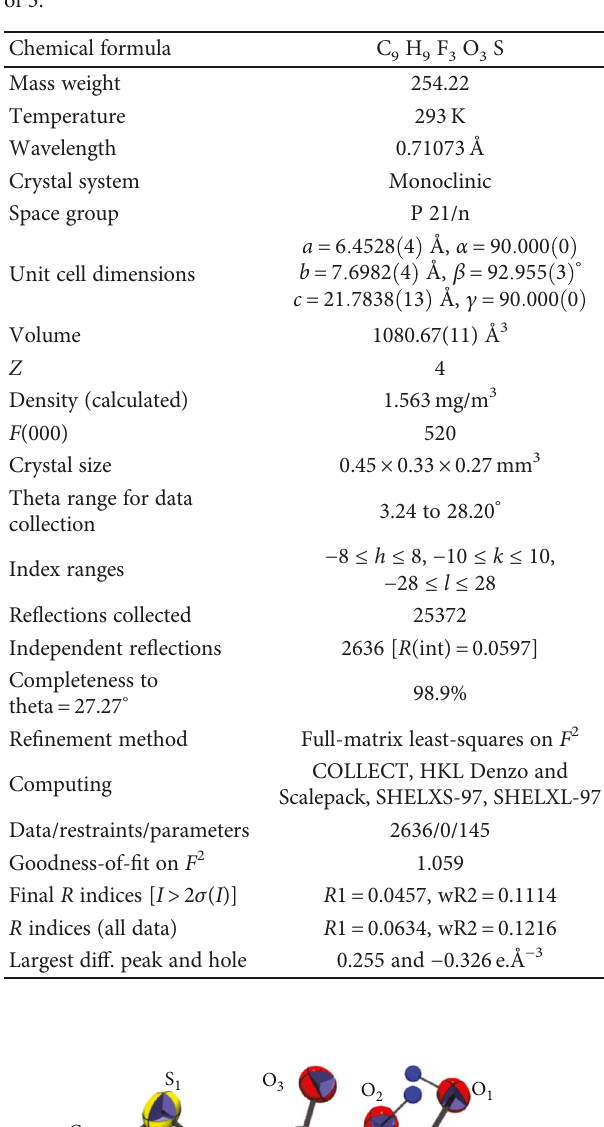
Table 2: Hydrogen-bonding geometry for 3 (Å and ° ).